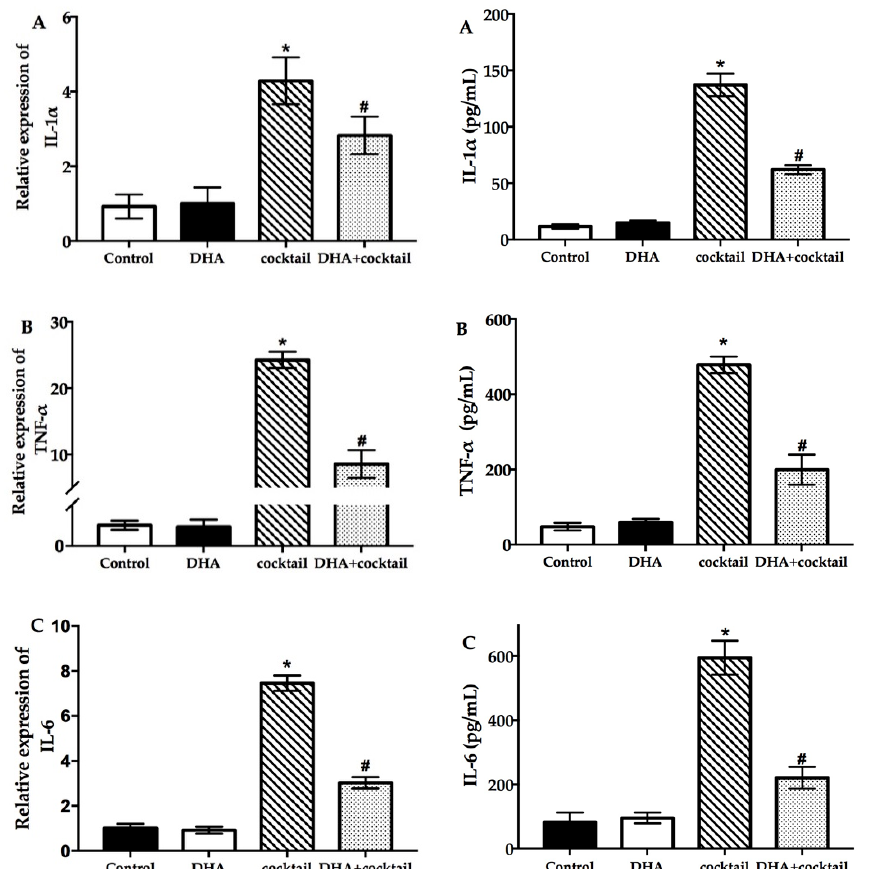
Figure 2. Effect of DHA on the inflammatory cytokine expression in NHEK cells with or without the cocktail (20 μ g/mL LPS plus 10 μ g/mL poly I:C). The results of real-time quantitative polymerase chain reaction and enzyme-linked immunosorbent assay show the changes of IL-1 α ( A ), TNF- α ( B ), and IL-6 ( C ) after incubation for 24 h. Data are presented as mean ± SD, n = 5. * Compared with the control group, p < 0.05; # compared with the cocktail (LPS plus poly I:C) treated group, p < 0.05. IL, interleukin; TNF, tumor necrosis factor; cocktail, 20 μ g/mL LPS plus 10 μ g/mL poly I: C.